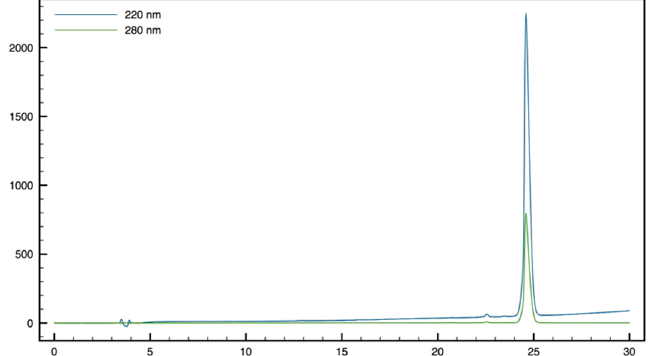
Figure 17 . HPLC profile of Gdm- β 2,2 -h-bis-Arg-Tbt-OMe 14 .